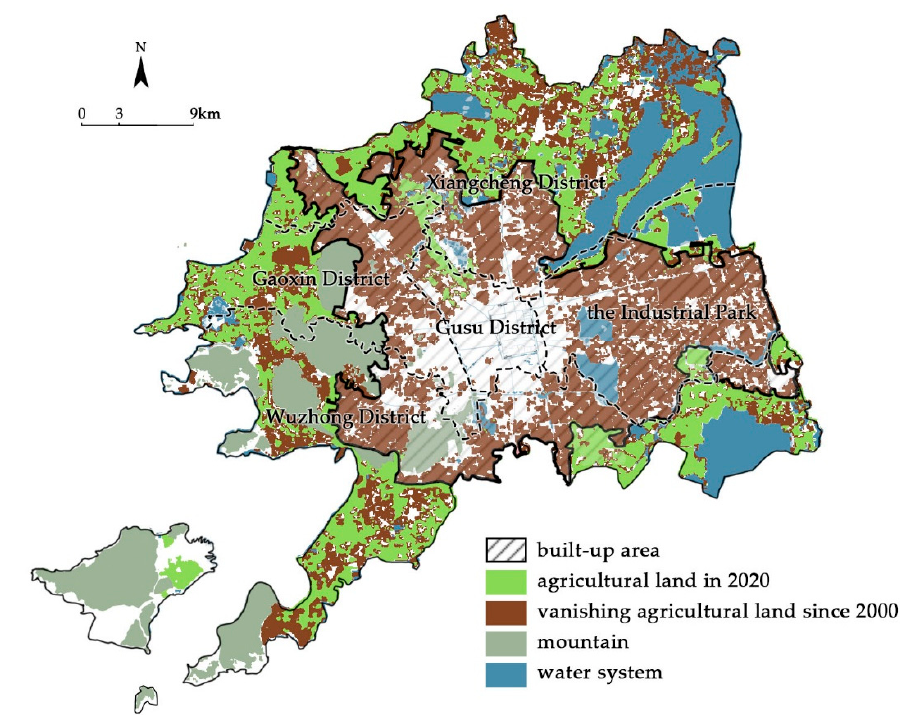
Figure 4. Agricultural land of Suzhou.